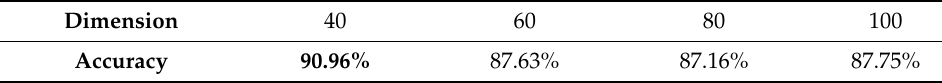
Table 2. Classification results using different feature vector dimensions.